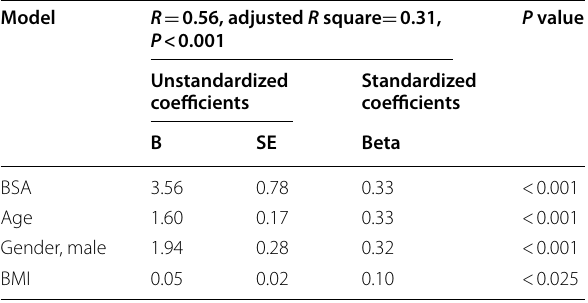
Table 29 Linear regression analysis to predict mean aortic diameter at pulmonary bifurcation